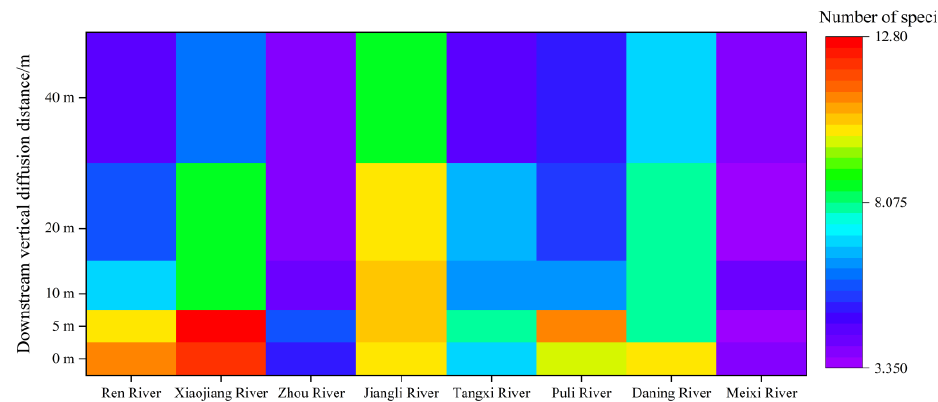
Figure 6. Heatmap of IAS close to and far from riverbanks.